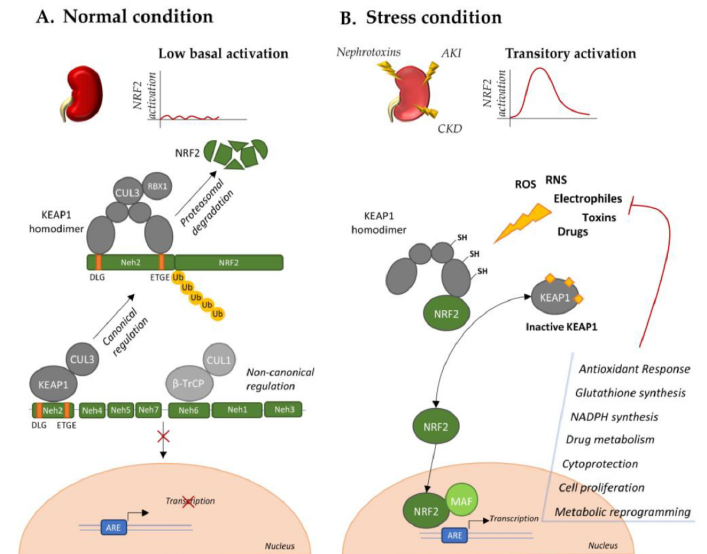
Figure 1. NRF2 regulation in normal and stress conditions. ( A ). NRF2 activity in normal condition is maintained at low levels through KEAP1-dependent canonical ubiquitination and KEAP1-independent noncanonical pattern. ( B ). Stress stimuli, through electrophilic binding of KEAP1, induce its conformational modification and release of NRF2. NRF2 nuclear translocation transiently activates, through MAF binding, the transcription of a signature aimed to counteract the initial